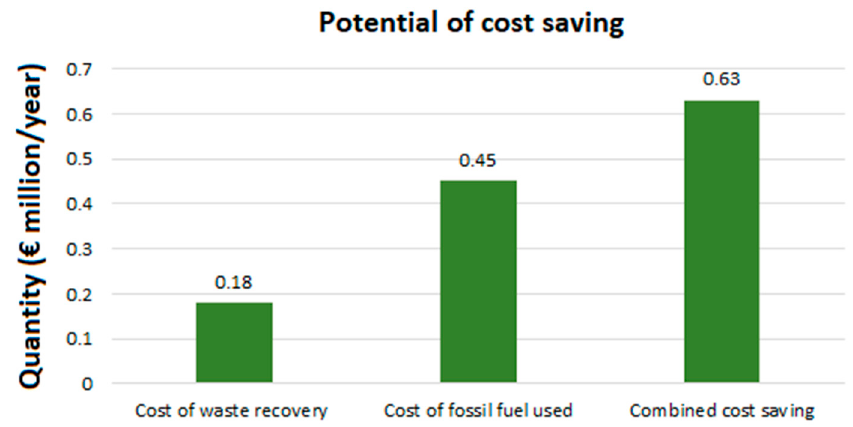
Figure 8. Optimal assessment of symbiotic environment in Sodankylä.